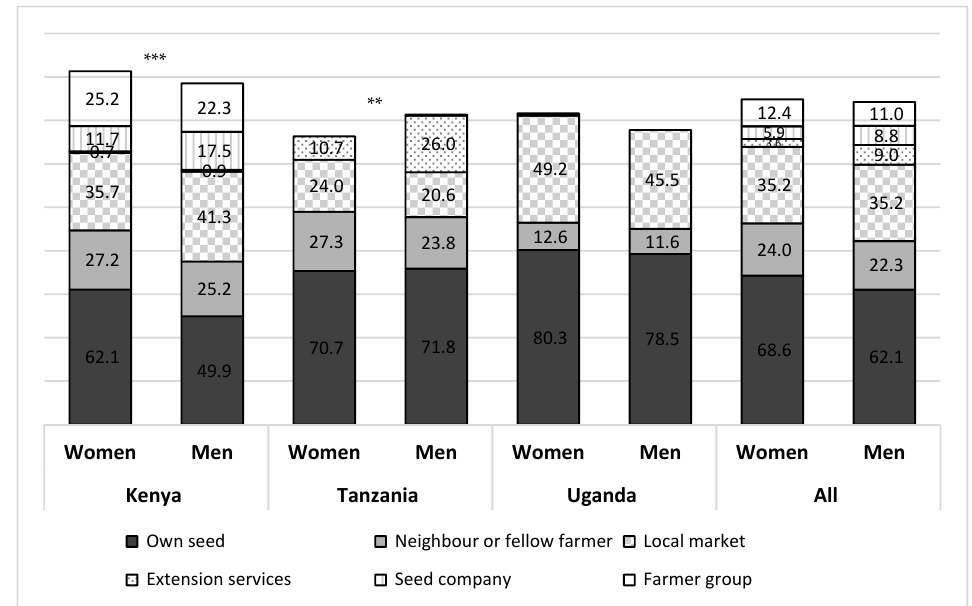
Figure 3. Seed sources, by country and sex (% of respondents). *** p < 0.01, ** p < 0.05 show significant association between respondent sex and seed source for that country using chi square tests.